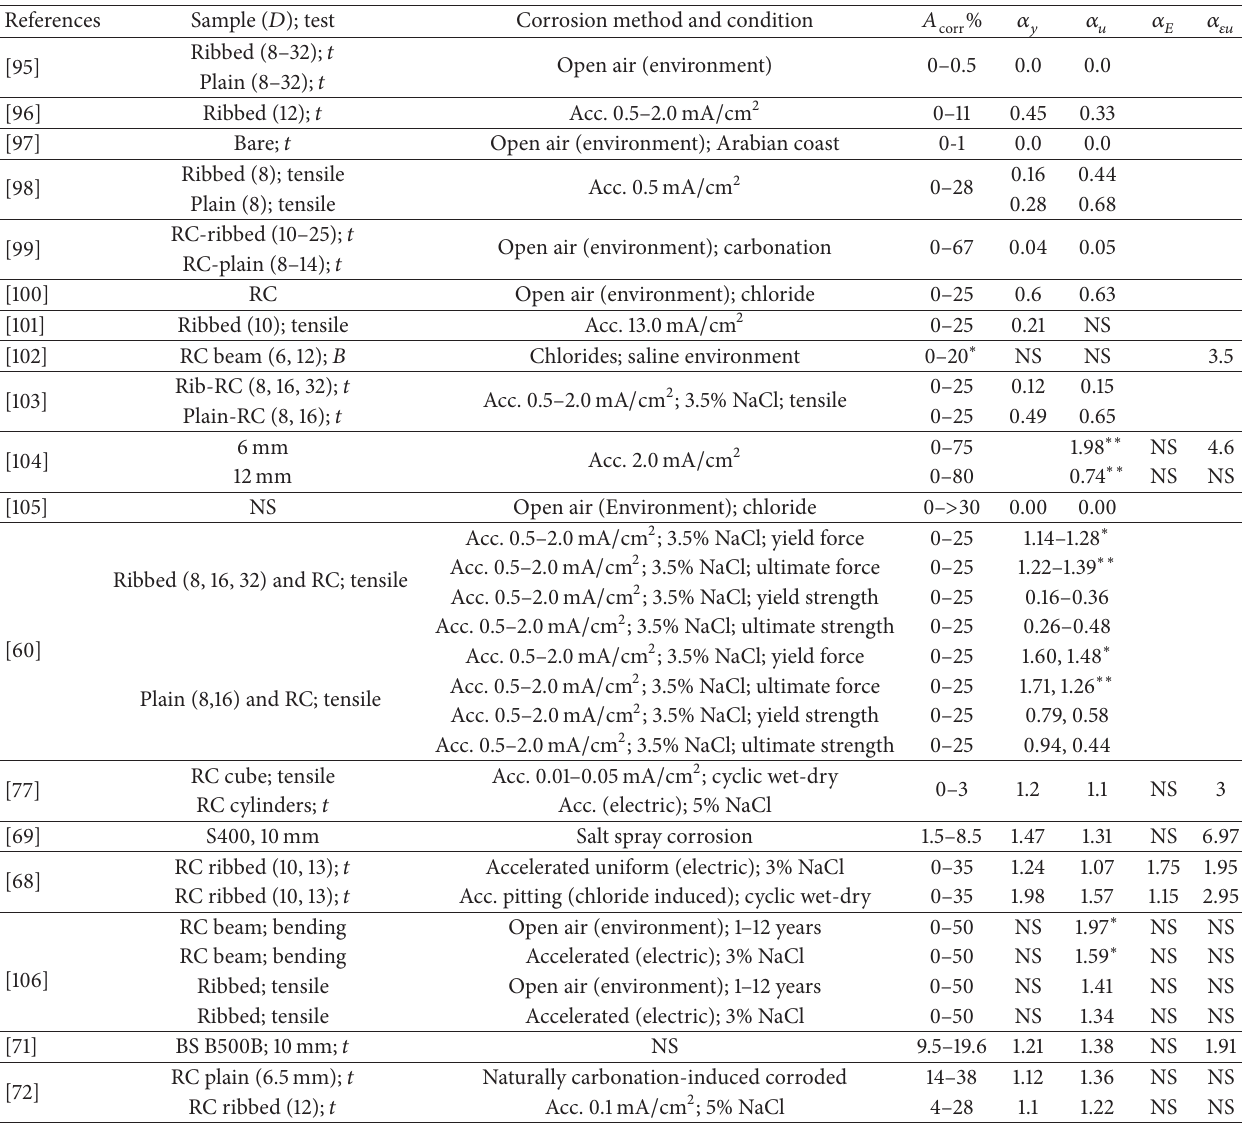
∗ indicates factor associated with yield force. ∗∗ indicates reduction factor associated with ultimate force.